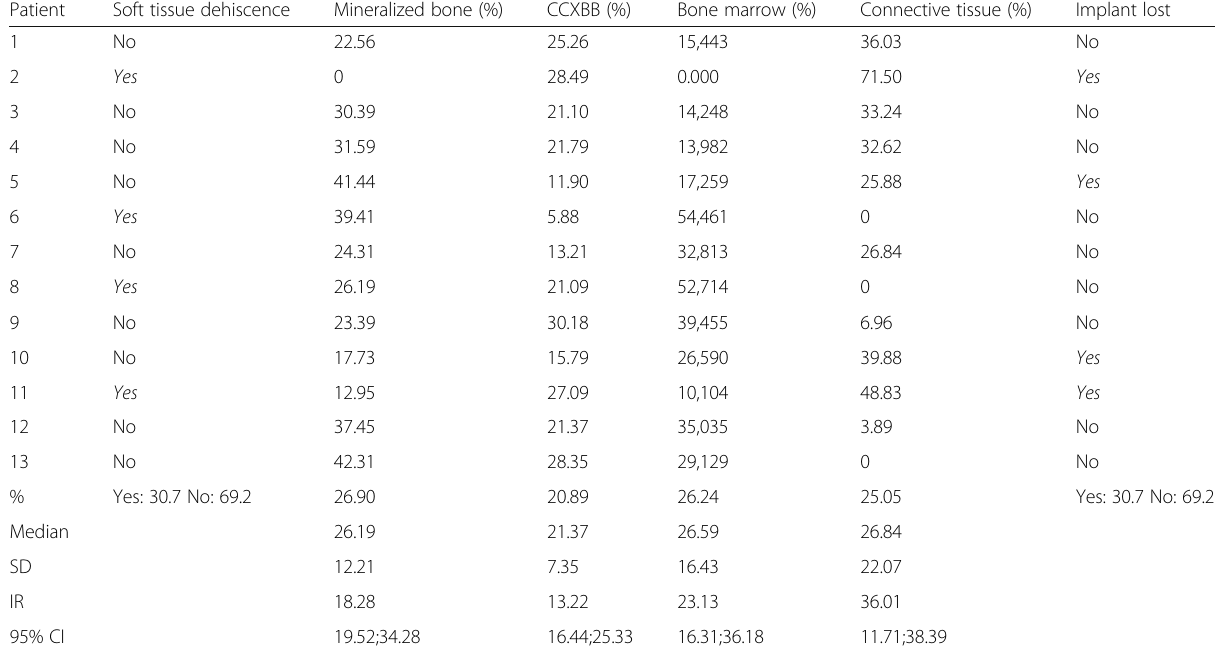
Table 1 Clinical and histomorphometry assessments (i.e., dehiscences, mineralized bone, CCXBB, bone marrow, connective tissue, and implant lost) Patient